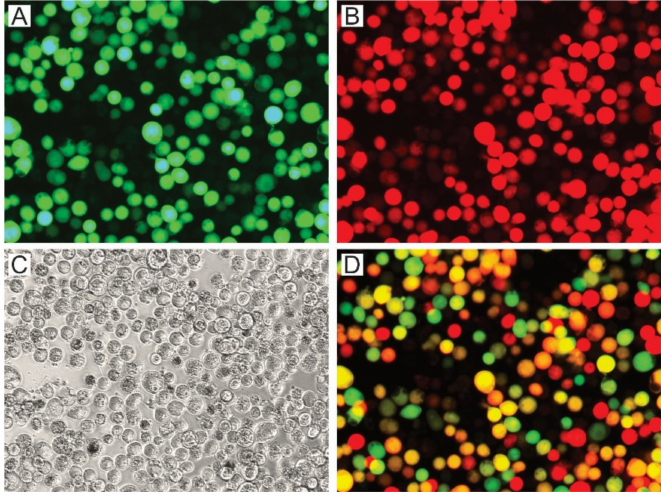
Figure 4. Production of viral OBs with P74 variants. AcMNPV per os infective virions with P74 variants were generated in Sf21 cells by the coinfection of BVs expressing those proteins and GFP, with BVs expressing polyhedrin and mCherry. Both BVs are based on the p74 -knockout bacmid. Representative microscopy photos (400 × ) are shown. ( A ) Green fluorescent cells showing that the infection induced GFP expression. ( B ) Red fluorescent cells showing that the infection induced mCherry expression. ( C ) Bright field (the presence of OBs can be seen). ( D ) Merged image obtained through combination of the previous images ( A , B